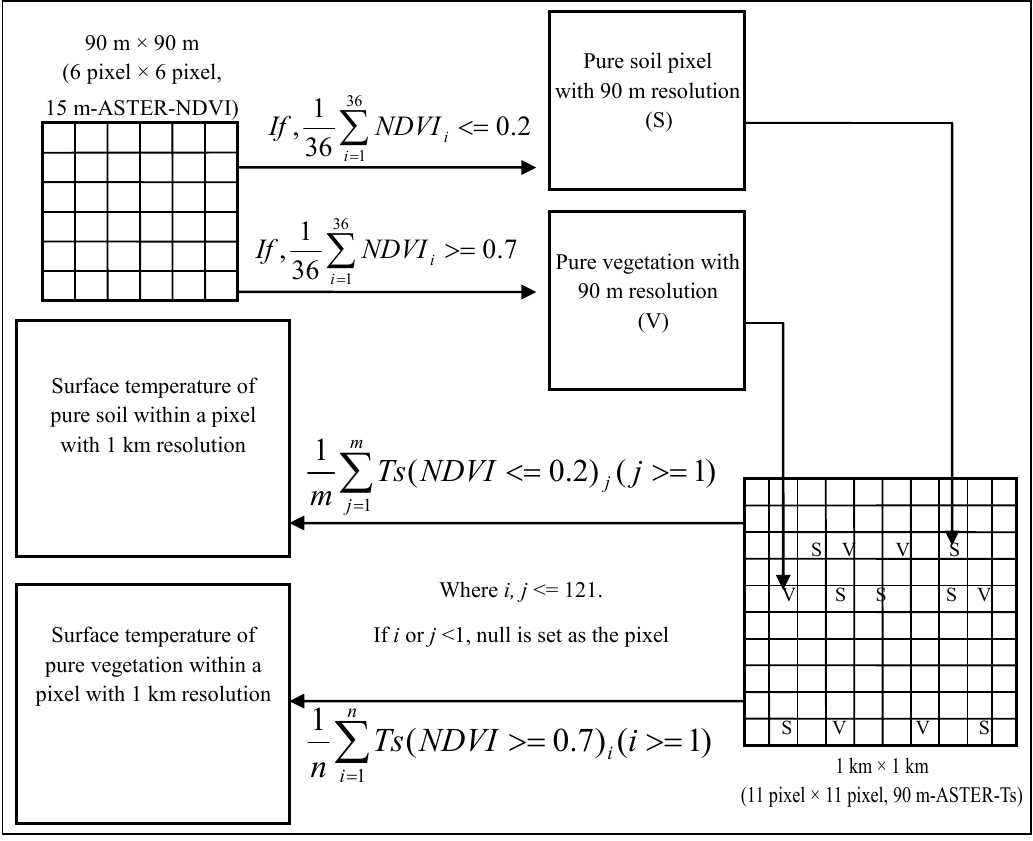
Figure 4. Procedure scheme of identifying the ASTER 90 m-pixels of pure soil and vegetation and obtaining Ts of pure soil and vegetation within a pixel with 1 km